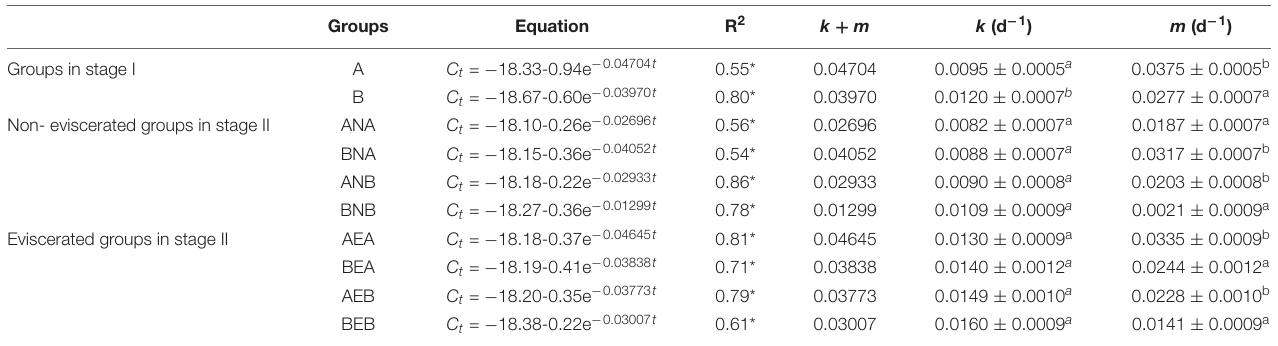
TABLE 4 | Summary of time-based stable isotope turnover models and related growth and metabolism parameters for body walls of A. japonicus .